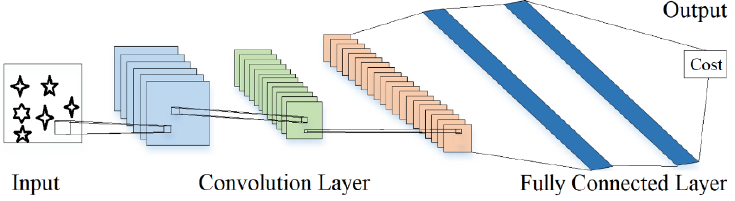
Figure 8. Structure of the CNN.